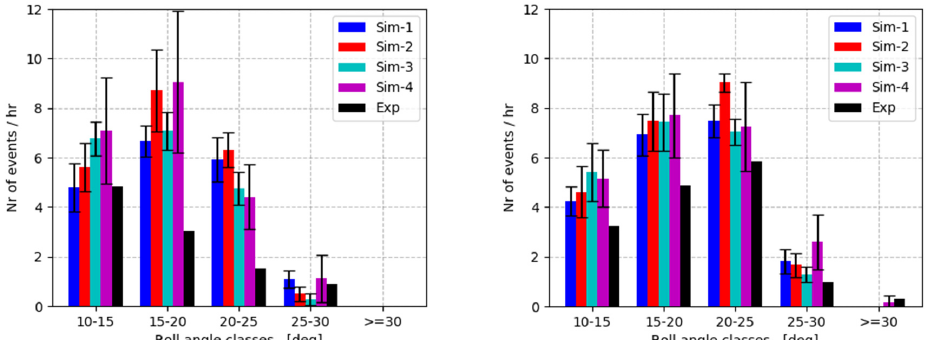
Figure 8. The number of parametric roll events per hour divided in classes of roll angles. Results of four sets of simulations, each the total of 10 simulations of 3 h duration, compared to results of experiments (3 h). The bars indicate the means and the error bars indicate the 95% confidence intervals obtained from 10 realizations for each simulation program. Left: Head sea with Hs = 7 m, Tp = 13.5 s, speed Vs = 7.6 kn, Right: Head sea with Hs = 8 m, Tp = 13.5 s, speed Vs = 7.9 kn.